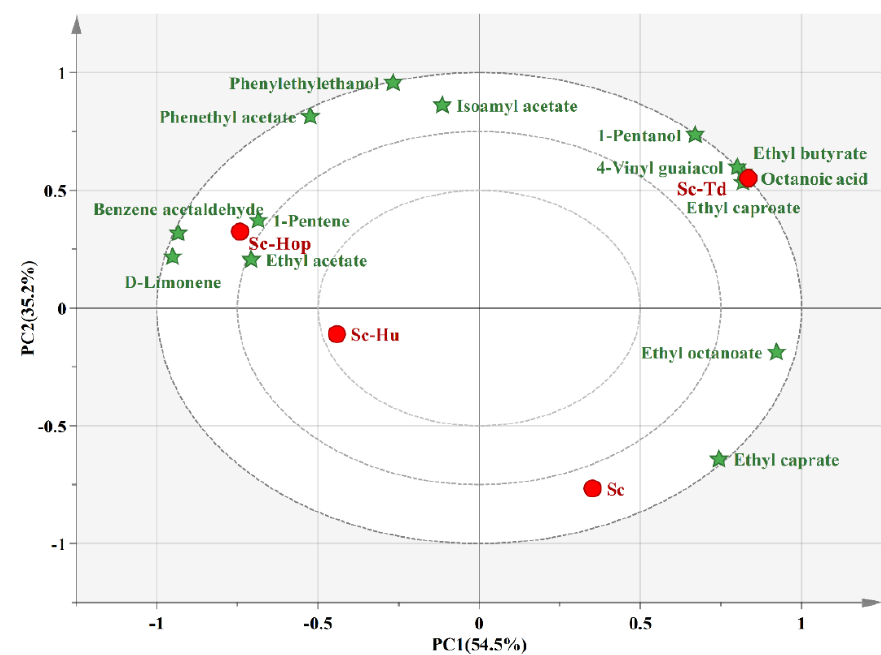
Figure 2. Principal component analysis of volatile aroma compounds in citrus wines. Sc-Hu, S. cerevisiae / H. uvarum co-fermentation; Sc-Td, S. cerevisiae / T. delbrueckii co-fermentation; Sc-Hop, S. cerevisiae / H. opuntiae co-fermentation; Sc, S. cerevisiae fermentation .